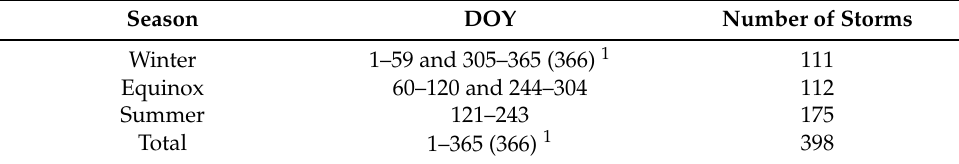
Table 1. Number of storms for each season together with the